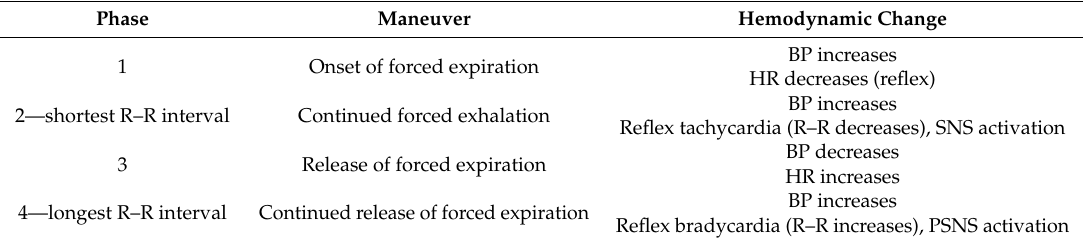
Table 1. The Valsalva maneuver: expected responses in healthy individuals